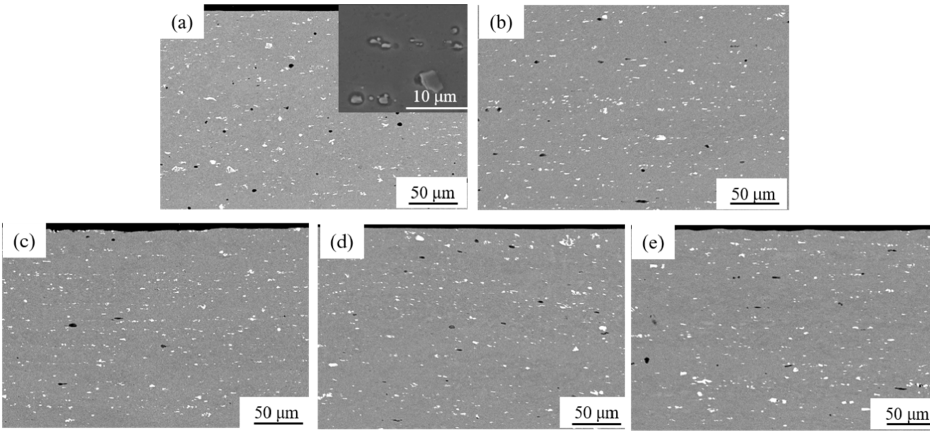
Figure 1. Optical metallographs of the as-annealed and cold-rolled AA6061 alloy; ( A ) surface region, and ( B ) center portion; ( a ) as-annealed, ( b ) Δt/t 0 = 10%, ( c ) Δt/t 0 = 30%, ( d ) Δt/t 0 = 50%, ( e ) Δt/t 0 = 70%, and ( f ) Δt/t 0 = 90%.